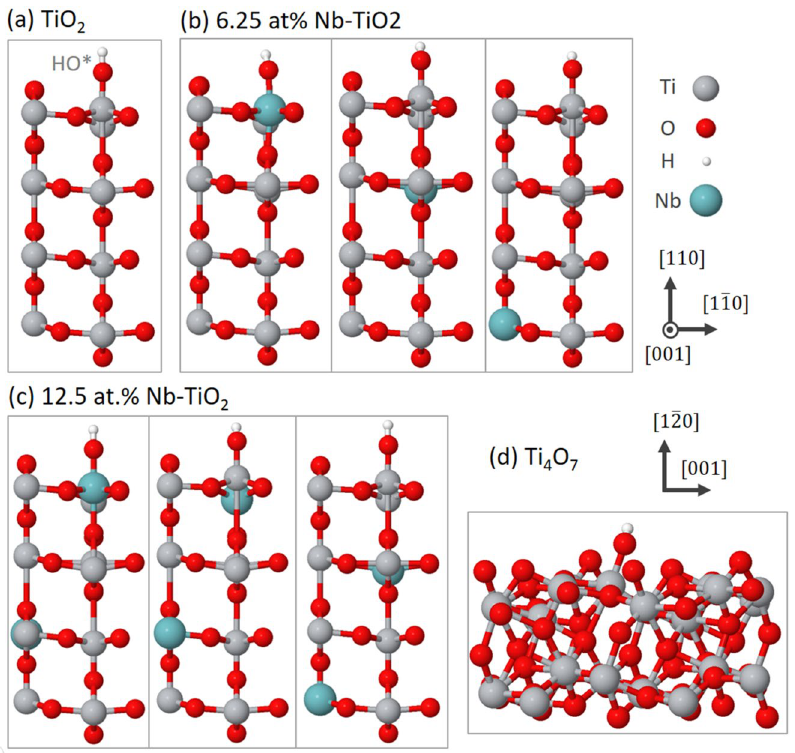
Figure 2. Structural models of the ( a ) TiO 2 ( 110 ) surface, the same surface with ( b ) 6.25 at.% and ( c ) 12.5 at.% Nb doping, and the (d) Ti 4 O 7 (cid:31) 120 (cid:30) surface. Multiple structures were generated for each doped material system to capture the strong effect of proximity of the dopants to the surface. The models are periodic in all three directions, with 20 Å of vacuum normal to the surface. For each system, the shown geometry resulted from optimization with bound HO*. Images generated using Jmol version 14.29 40